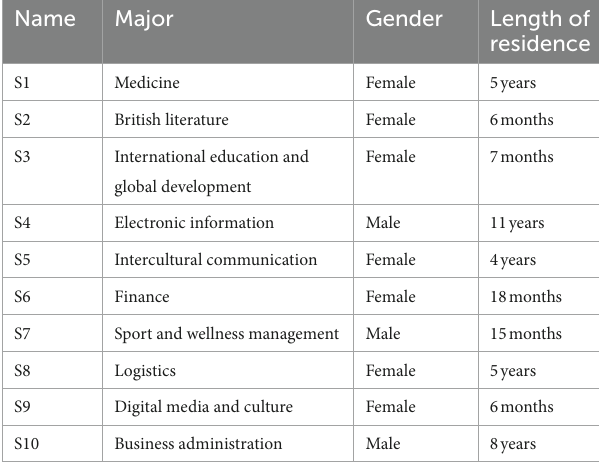
TABLE 1 The profile of interviewees.